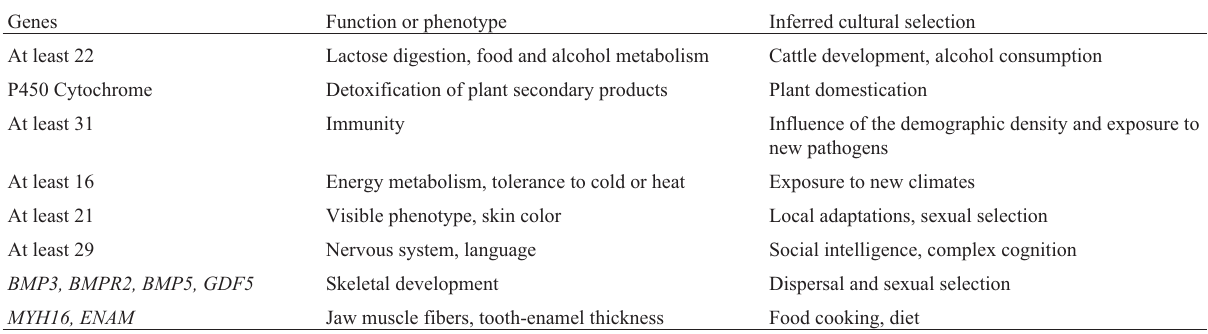
Table 4 - Genes identified as subjected to fast positive selection and inferred cultural selection. Genes Function or